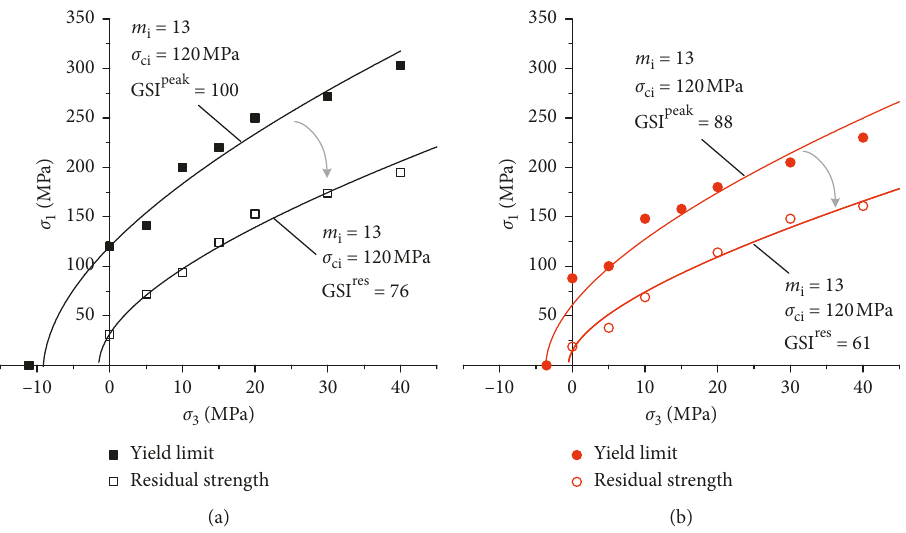
Figure 8: Envelope of the yield limit and the residual strength. (a) Intact rock. (b) Rock